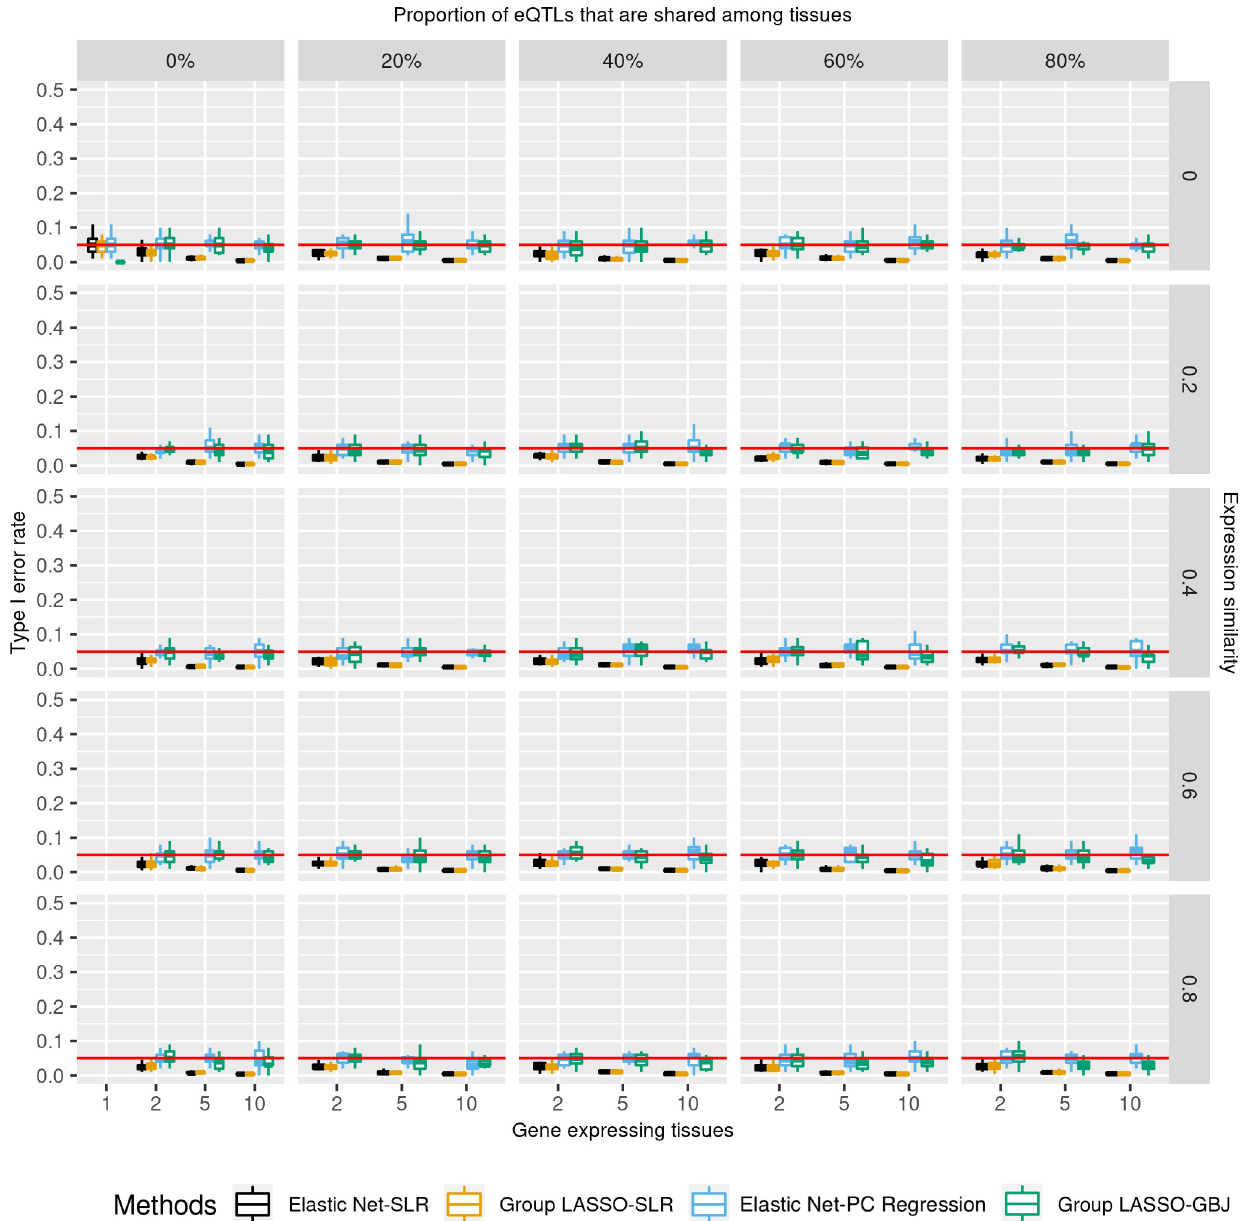
Fig 3. Type I error rates of different TWAS methods in prioritizing genes of diverse tissue specificity properties. Type I error rate was the probability that TWAS wrongly identified a gene-trait association as significant while there was not any signal simulated in the dataset. Association p-values were controlled for the number of genes and tested tissues. X-axis is the number of gene-expressing tissues. Each column stands for the proportion of eQTLs that are shared among tissues for a gene. Each row is the similarity of gene expression profiles across tissues which is estimated by correlation. Moving from the top left to the bottom right is a gradient spectrum from tissue-specific genes to broadly expressed genes. The colors represent different TWAS methods and y-axis is the type I error rate. All TWAS methods had controlled type I error rates ( �